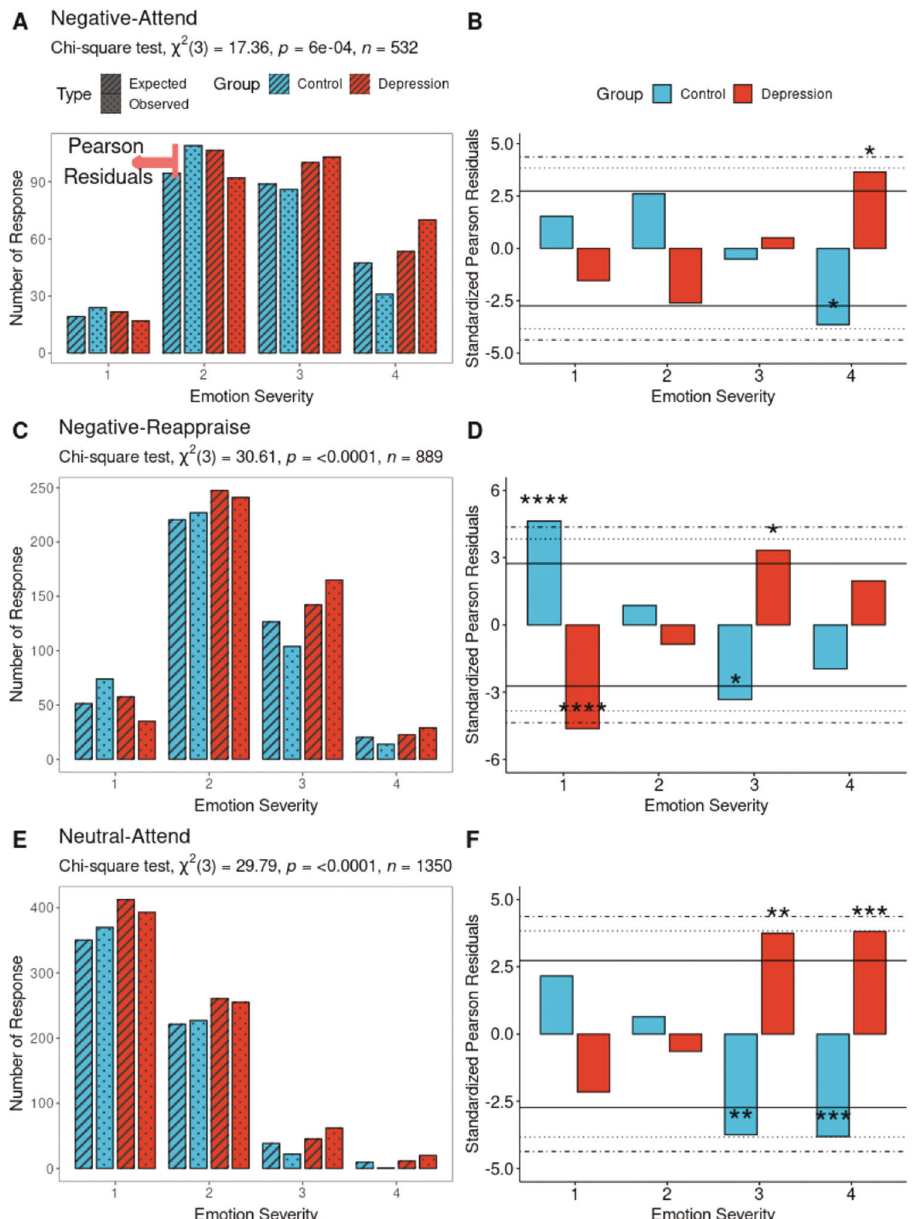
Fig. 3 Comparison of emotion severity in reaction to negative and neutral stimuli in MDD and controls. The left column shows emotion severity from 1 to 4 when subjects encounter negative or neutral stimuli. The left column shows the observed number of responses (striped) and expected number of responses (dotted) according to the chi distribution. The Chi-square test ’ s Z-normalized (standardized) Pearson residuals show signi fi cant differences between observed and expected responses. In the right column, standardized Pearson residuals show whether the observed response is signi fi cantly different from the expected response according to the chi-square distribution. The horizontal solid line represents the p = 0.05 cut-off for z-normal standardized residuals. The horizontal dotted line represents p = 0.001, and dot-dashed line represents the p = 0.0001 cut-off. A During negative stimuli with attending, group difference is related to emotion severity in the Chi- square test. B The MDD group shows strong emotional reaction to negative stimuli while attending. C During negative stimuli with reappraising, group difference is shown in emotion severity in the Chi-square test. D During reappraising the negative stimuli, the control group shows weak emotional response (1), whereas the MDD group exhibits moderate response (3). E While attending the neutral stimuli, group difference is shown in emotion severity in the Chi-square test. F the MDD group exhibits higher emotional response to neutral stimuli, whereas the control group did not show such pattern. Asterisks implies signi fi cance; * p < 0.05, ** p < 0.01,*** p <0.001, **** p < emotional response is related increased interoceptive GSCORR, range ((0.01 to 0.1 Hz) (as distinct from the faster frequency where we miss relationship between exteroceptive and mental range >0.1 Hz) for mediating the modulatory impact of layer with behavior. increased global neural activity related to the different facets of self (interoceptive, exteroceptive, mental) on the regulation Reappraising the emotion: In the global signal correlation model of negative emotion, e.g., emotion attention. Applying a model for negative reappraisal, model accuracy was 56% with a p = 0.022 with GSCORR with GSR (Supplementary Fig. 14), only weak